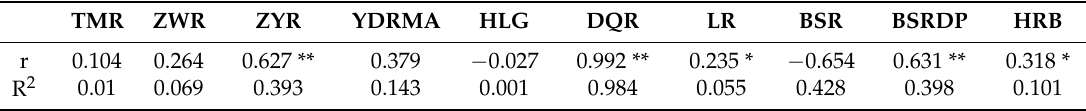
Table 5. Pearson correlation coefficients (r) and R 2 between calculated EI and RI in the Haihe River